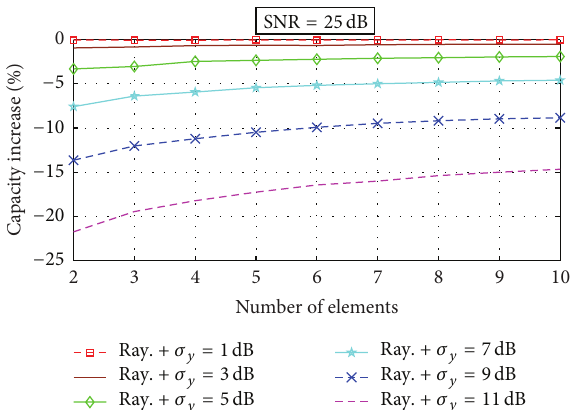
Figure 5: Capacity Increase versus number of elements shadowing 𝜎 fading, with SNR = 25